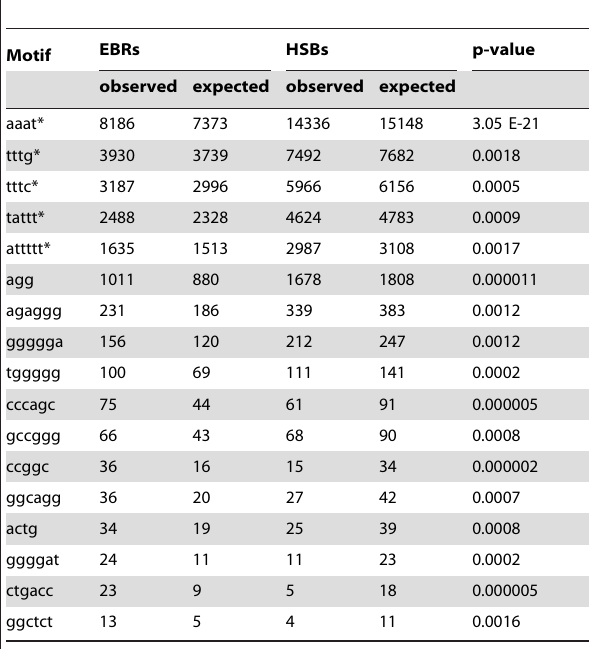
Asterisks indicate the overrepresented motifs (more than 1000 repeat units detected, see text for